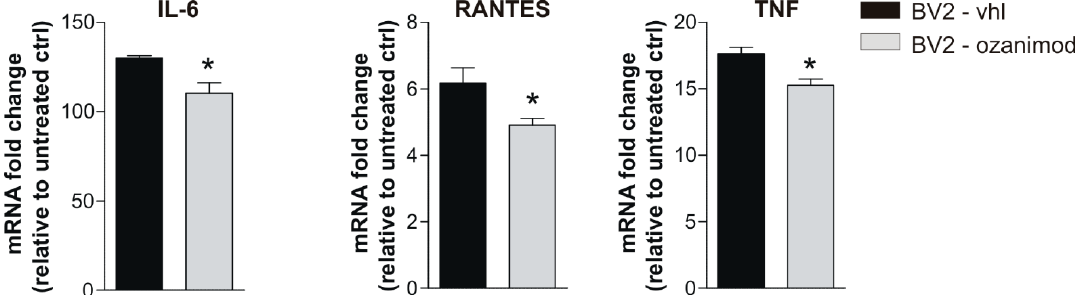
Figure 4. In vitro treatment of BV2 cell line with ozanimod modulates mRNA levels of pro-inflammatory cytokines. qPCR experiments performed on BV2 microglial cells activated by Th1 Mix for 2 h and incubated with ozanimod (1000 nM, 1 h pretreatment) or vehicle (DMSO) show a downregulation of IL-6, TNF and RANTES mRNAs. All data are expressed as mean ± SEM and as fold change of untreated controls. Unpaired t -test, * p < 0.05.